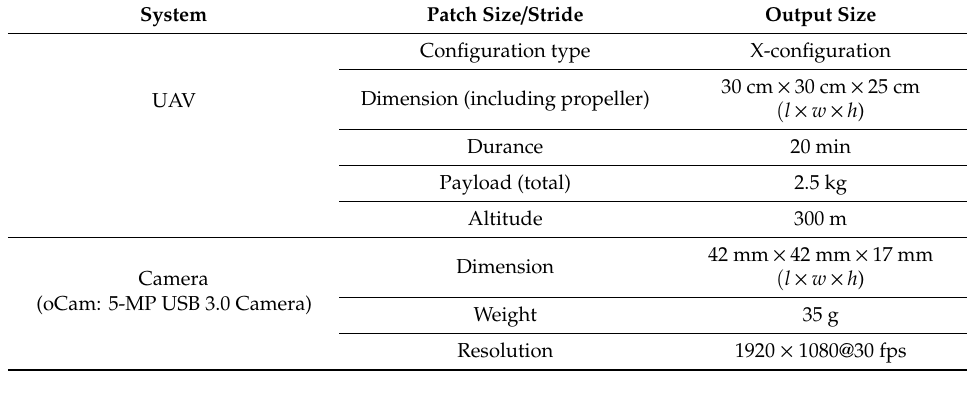
Table 1. Specifications of the drone and camera.